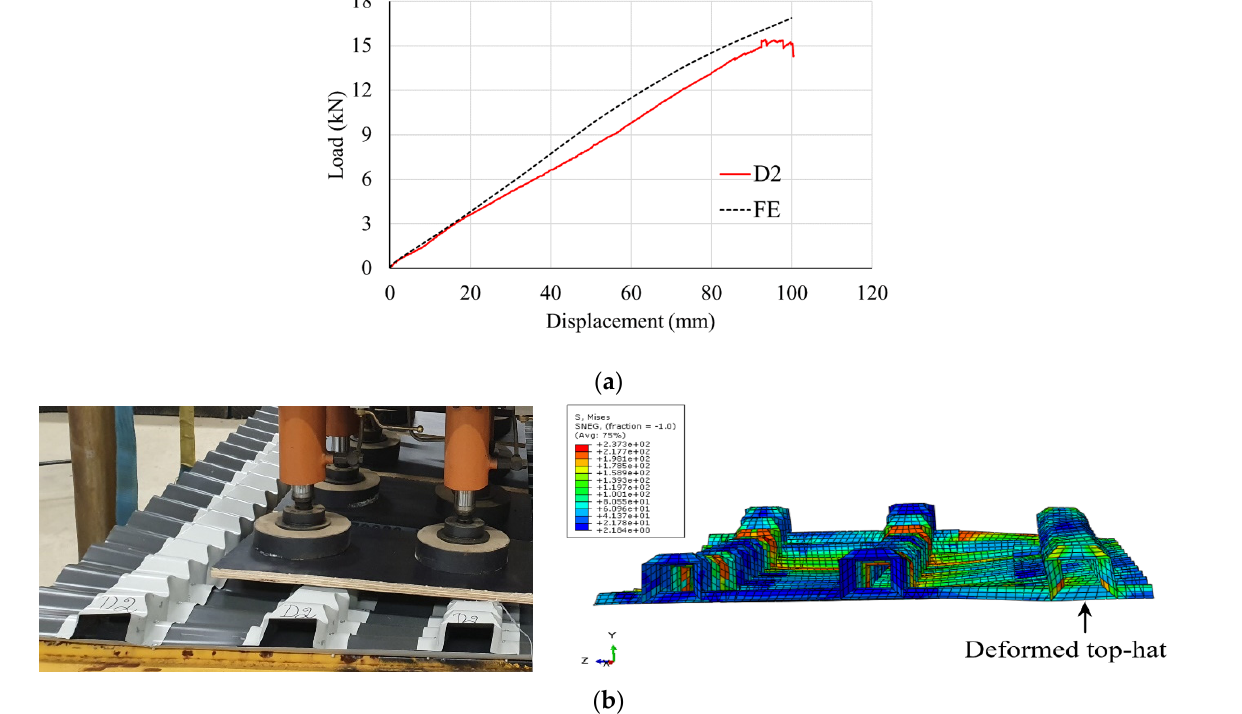
Figure 8. Validation of FE model results. ( a ) Load-displacement comparison of experimental result and FE result. ( b ) Failure mode comparison of the experimental deck and FE deck model.